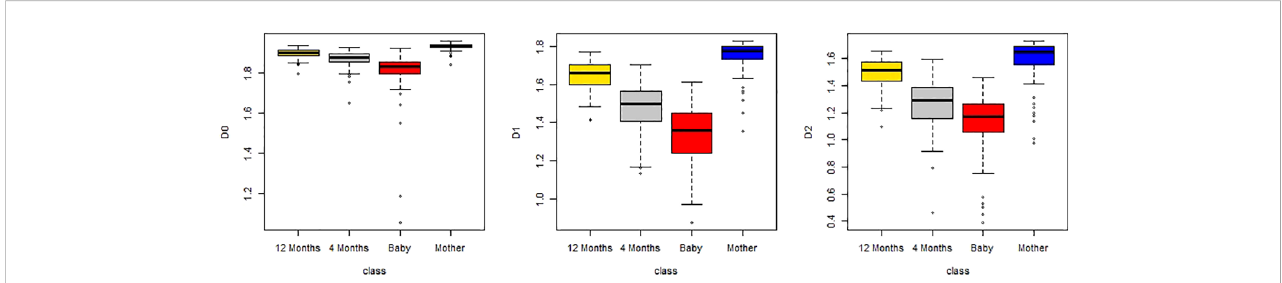
FIGURE 8 Boxplots of D(0), D(1), and D(2) of multifractal dimension of gut microbiomes of infants when they are 12 months old, 4 months old, and a baby, and that of the mother.